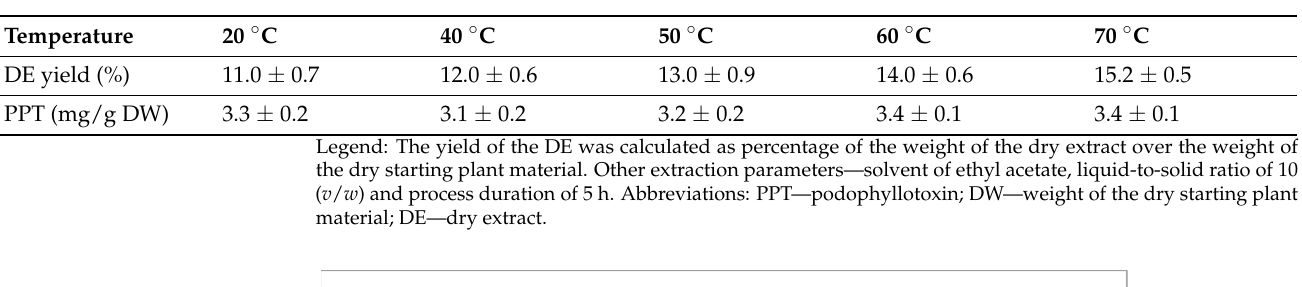
Table 2. Effect of the temperature on the total yield of the juniper leaf extracts and on the PPT recovery relative to the weight of the starting plant material.